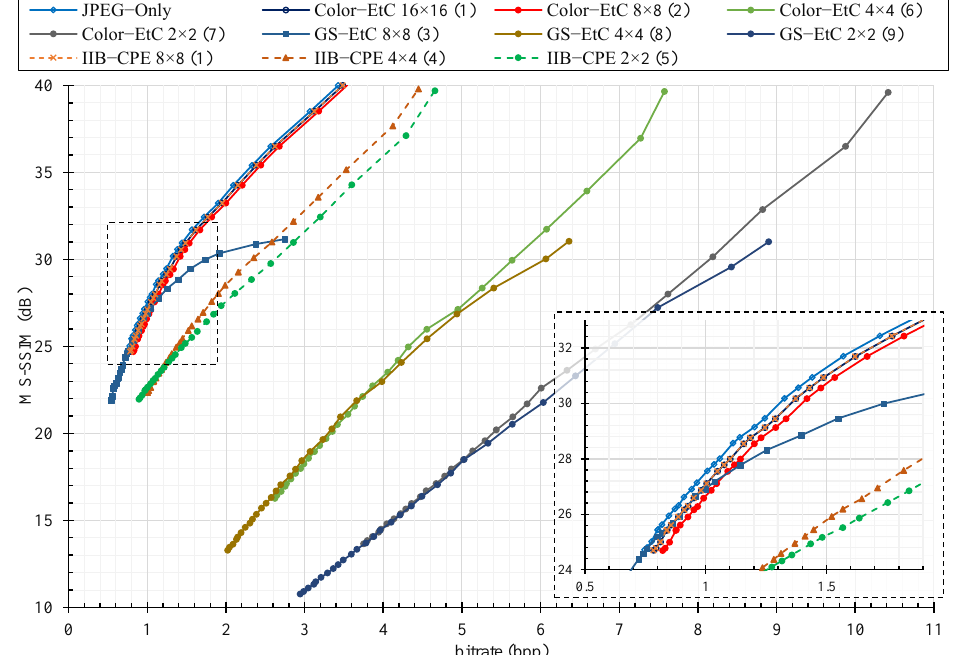
Figure 6. The JPEG compression performance without chroma subsampling on different perceptual encryption methods in terms of rate distortion (RD) curves with respect to MS – SSIM (dB) on Tecnick color dataset. The number enclosed in parentheses at the end of each series name shows its performance rank. The overlapping regions in the graph are zoomed in and shown in the bottom right corner.